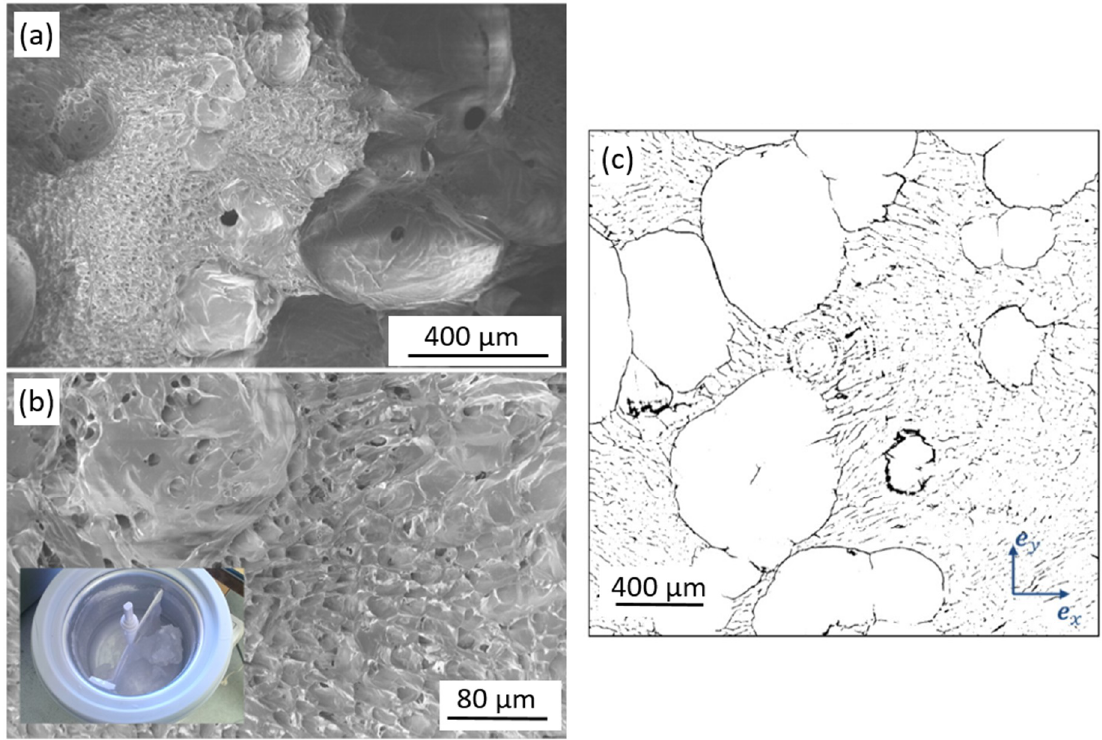
Figure 6. ( a ) SEM micrographs showing the microstructures of a TEMPO-oxidised CNF foam obtained using a sorbet-like process. In ( b ), the photograph inset shows the sorbet machine used to apply mechanical stirring during the freezing of CNF suspensions. ( c ) Horizontal cross-section of the TEMPO-oxidised foam obtained using X-ray microtomography (voxel size: 1.6 3 µ m 3 ). (Adapted from Martoïa et al. [56] with permission from Elsevier).